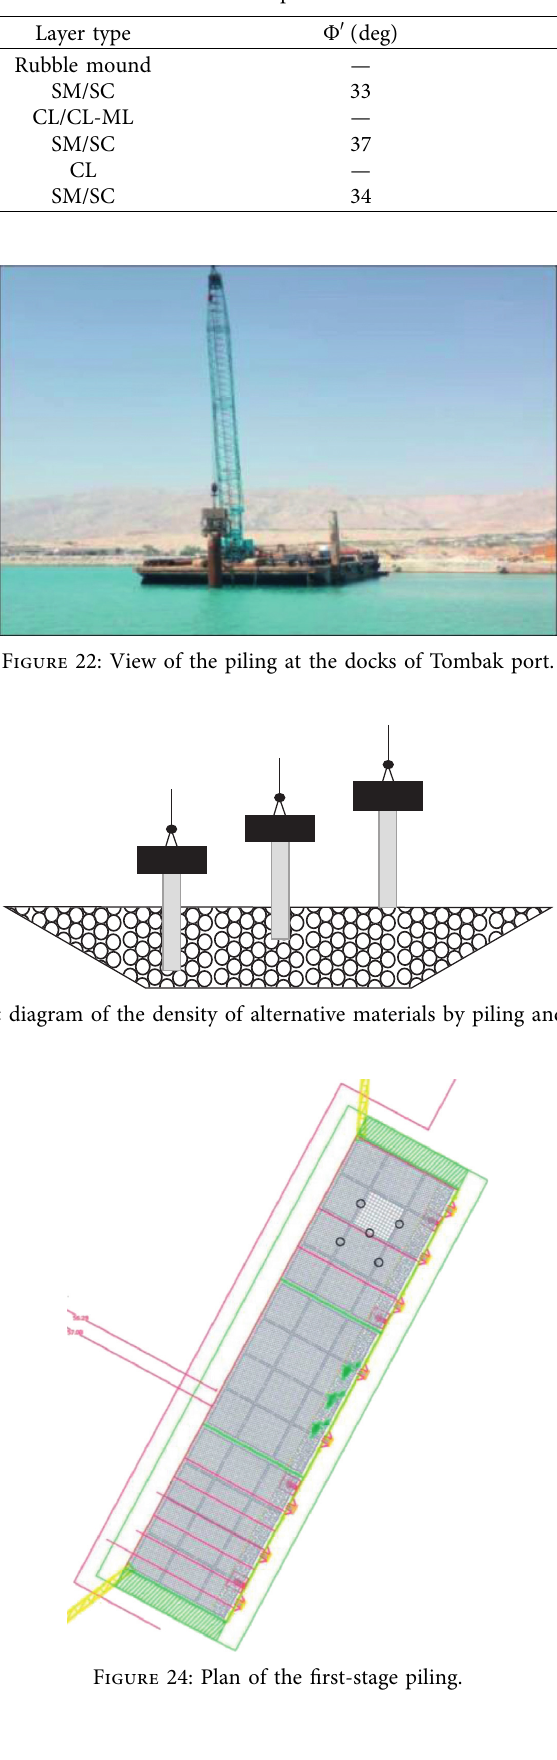
Table 2: Geotechnical profile of LPG1 wharf.